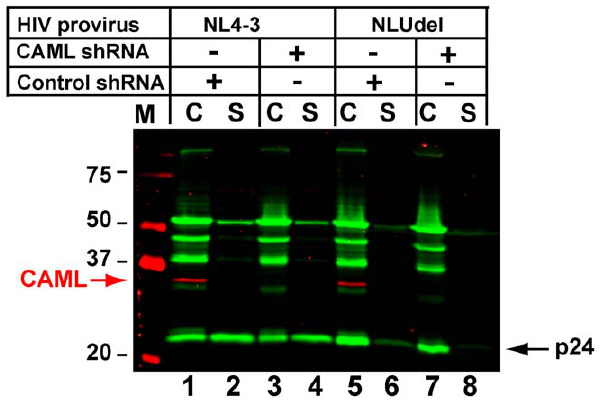
Figure 4. Depletion of CAML in HeLa cells fails to relieve restriction to particle release. A stably-transduced cell population demonstrating marked CAML knockdown (lanes 3, 4, 7, 8) was transfected with NL4-3 or NLUdel proviral DNA and compared with control shRNA transduced cells (lanes 1, 2, 5, 6). CAML protein is shown in red. In the presence of Vpu, particle release was equivalent in CAML knockdown or control cells (lanes 1–4). In the absence of Vpu, the restriction to particle release was present and was not affected by CAML depletion (lane 8 vs. lane 6).